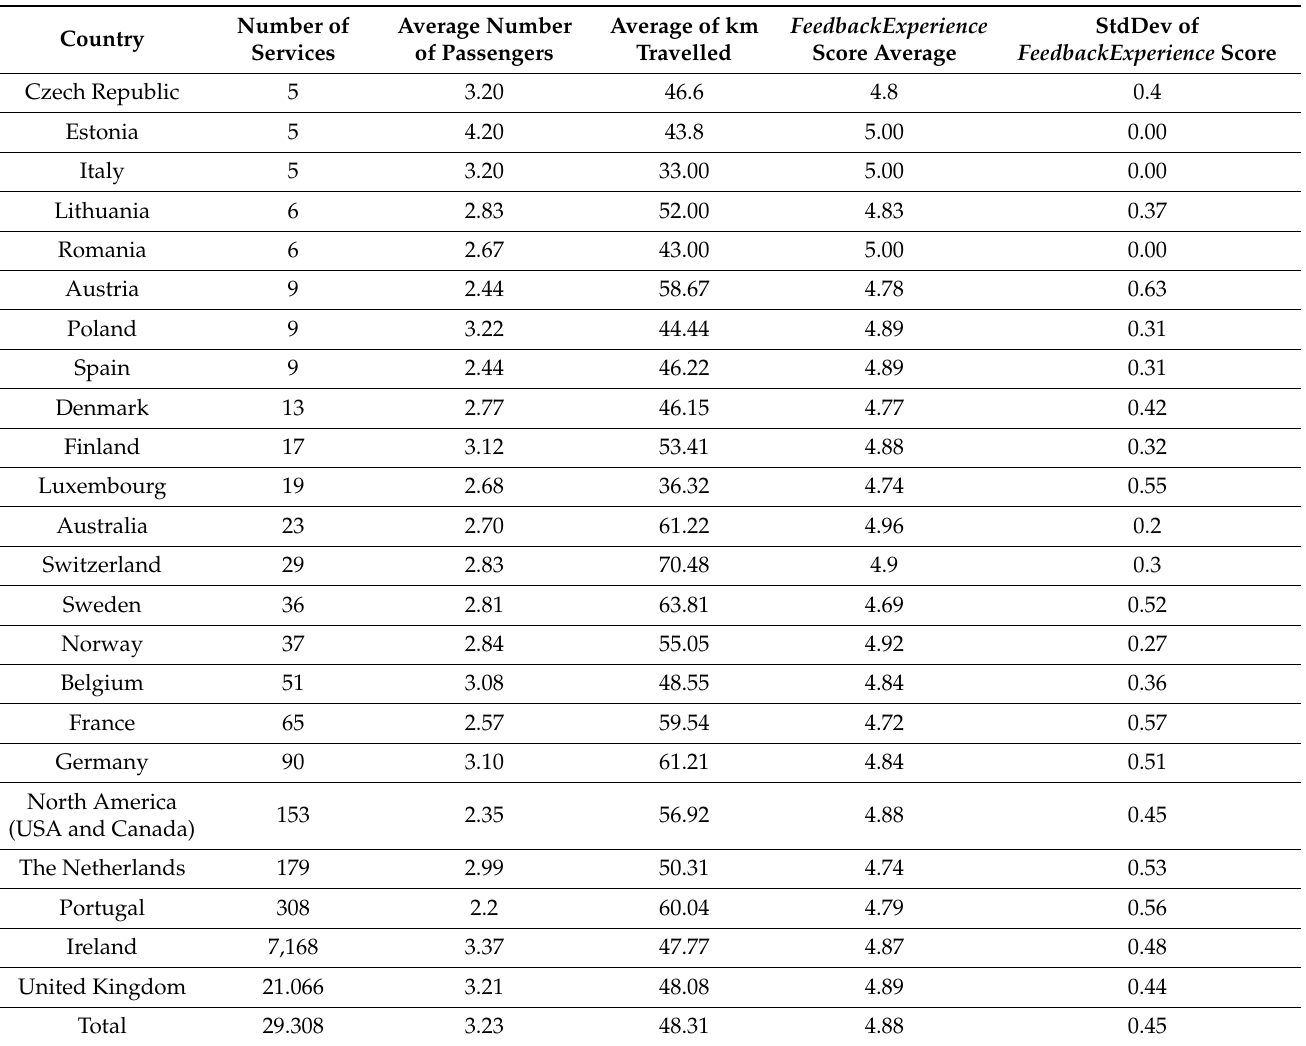
Table 3. Service characterisation by country and by customer experience